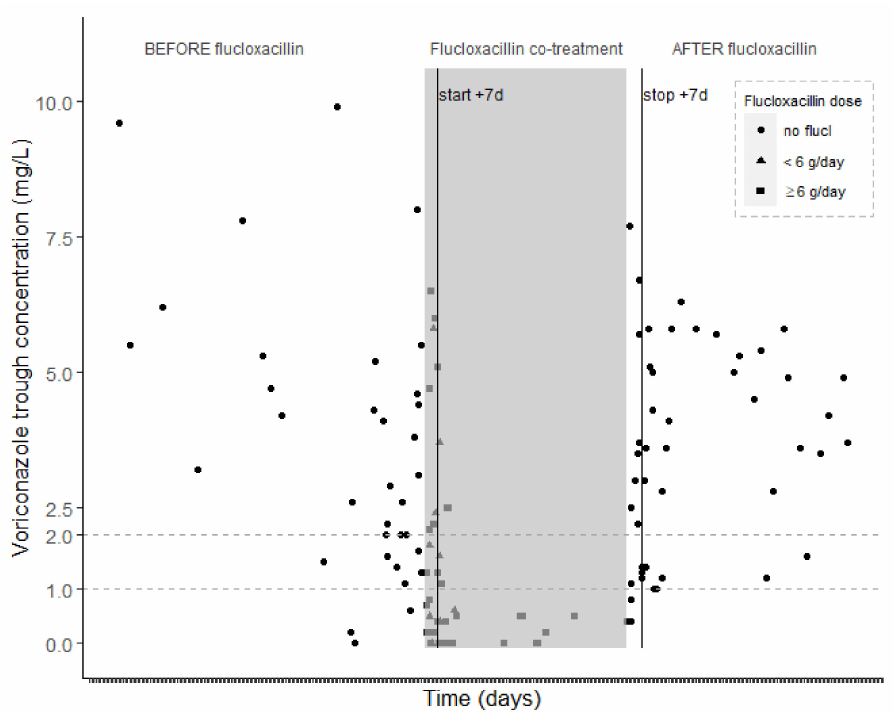
Figure 1. Voriconazole concentration as a function of time before, during, and after association of flucloxacillin. The grey area represents the time period in which flucloxacillin was administered in combination with voriconazole. The white areas are the periods of time of voriconazole admin- istration before and after flucloxacillin therapy, respectively. Each break on the x-axis represents one day and is depicted relative to the start and stop of flucloxacillin administration. Black dots: voriconazole concentrations without flucloxacillin; grey triangle/square: voriconazole concentrations while treated with flucloxacillin, depending on the administered dose. The black vertical solid lines illustrate the 7th day after the initiation and the stop of